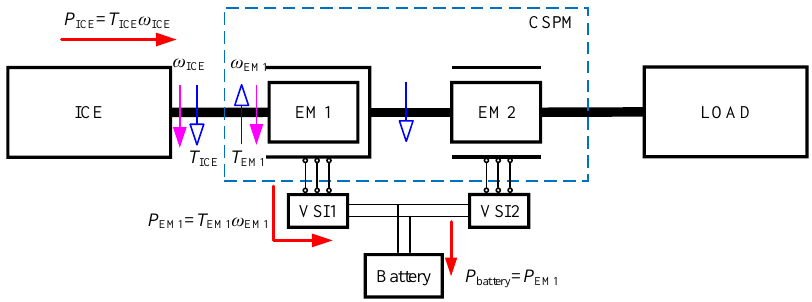
Figure 5. Generating mode and the related power flow diagram.